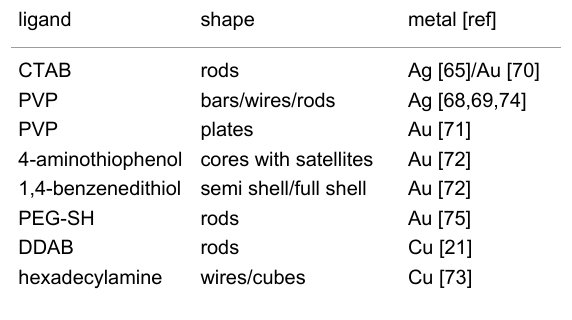
Table 1: Ligand-directed shapes of coinage metal